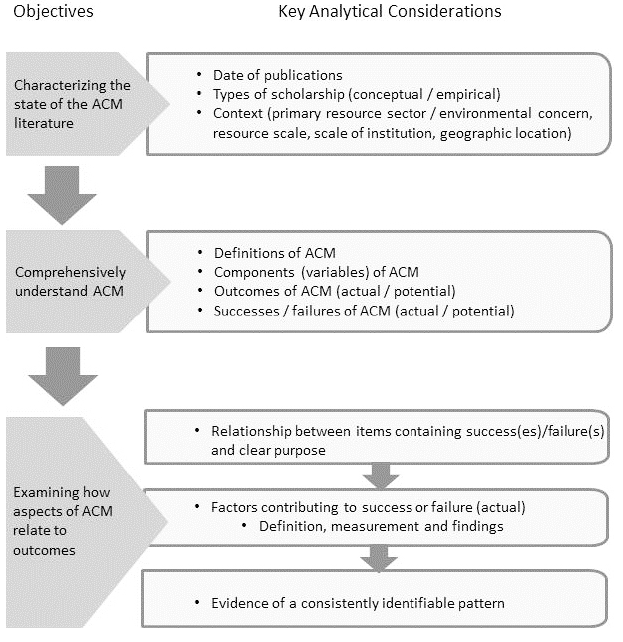
Fig. 1. Flowchart of study objectives and key